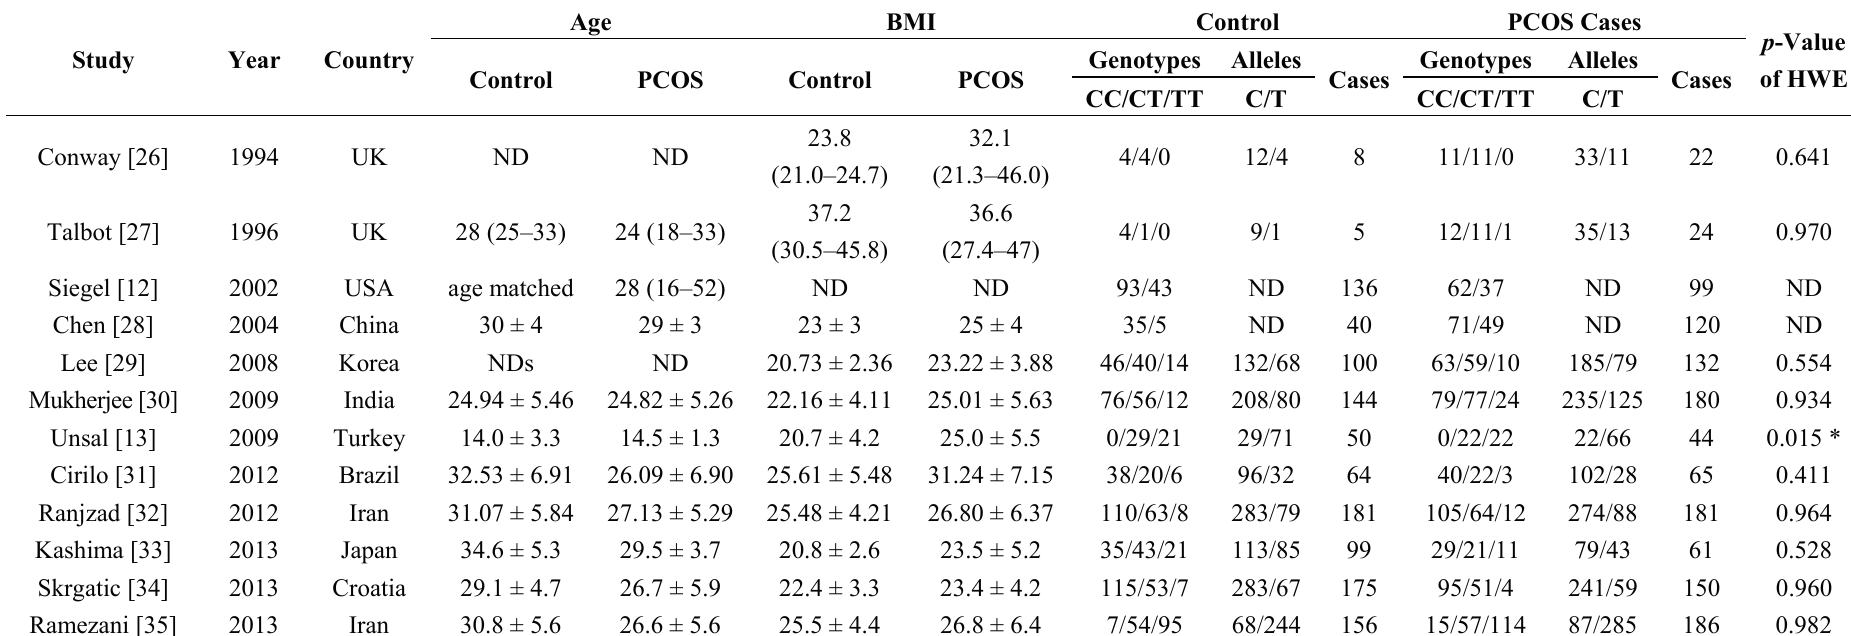
Table 3. Distribution of INSR rs1799817 genotype and the allele frequencies for controls and PCOS